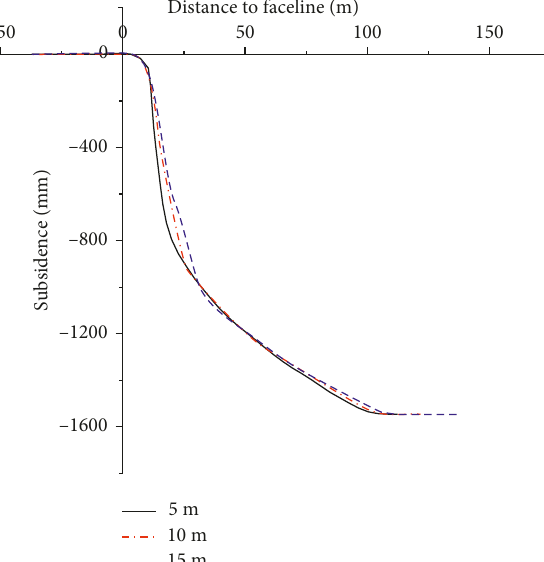
Figure 8: Influence of the block length on the subsidence of the voussoir beam structure.